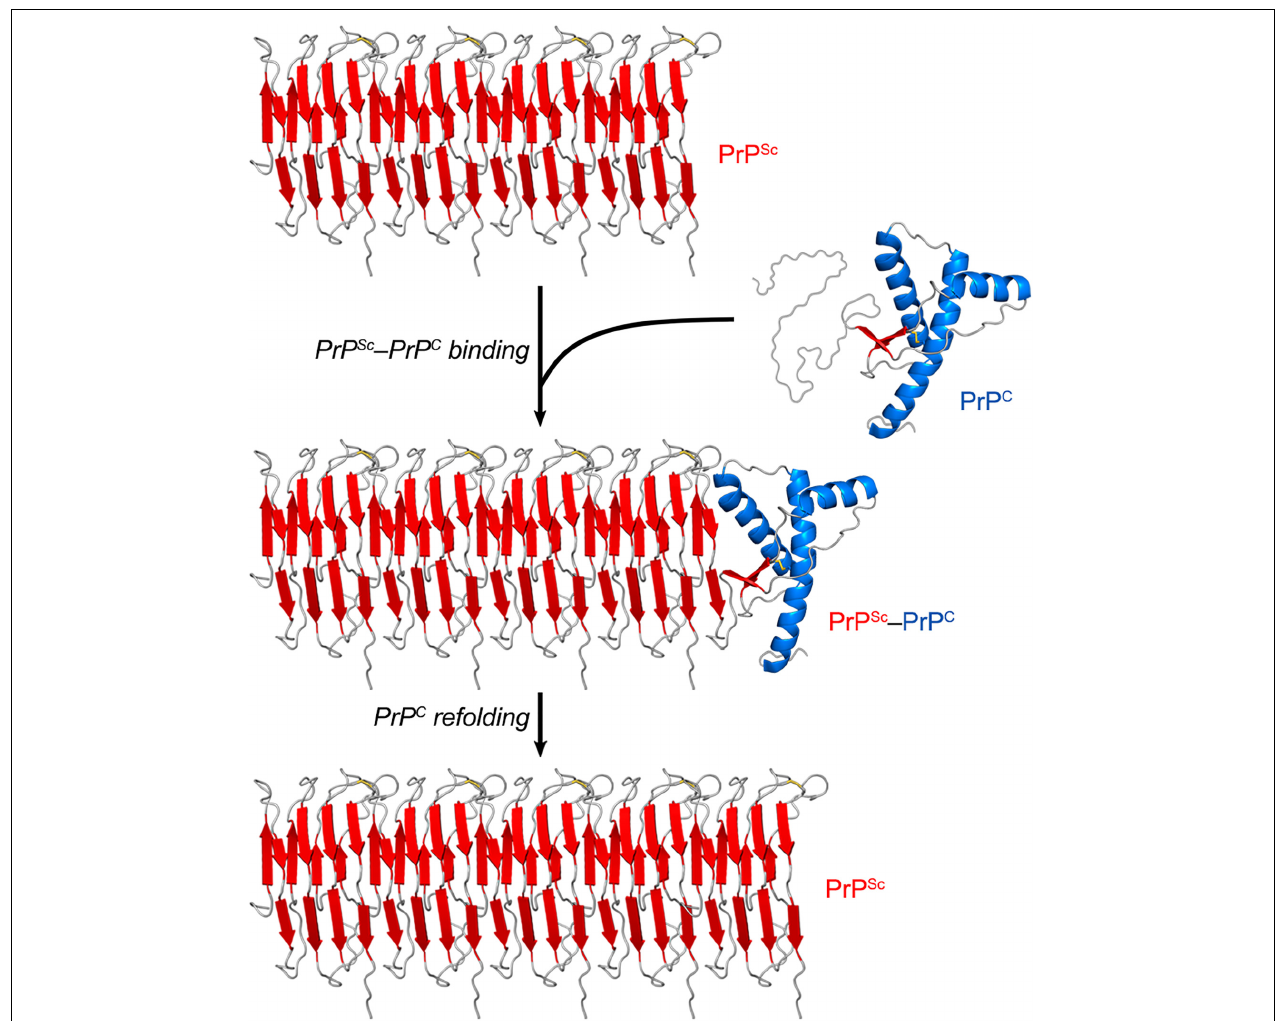
FIGURE 2 | PrP Sc amplification from PrP C . PrP Sc particles grow by a nucleation process. A unit of PrP C forms a complex with PrP Sc , and the latter induces the refolding of the former into a β -sheet-rich structure which then becomes part of the PrP Sc multimer. In this self-propagating process, the PrP Sc particles act like seeds/nuclei, with PrP C serving as a substrate. The secondary structures are colored as follows: α -helices in blue, β -strands in red, and unstructured portions in gray. The atomistic model of PrP Sc was constructed by combining experimental data and molecular dynamics simulations (Spagnolli et al.,